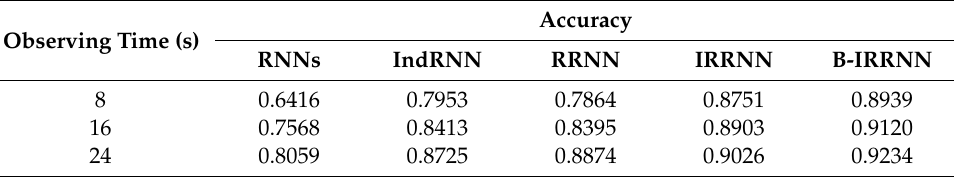
Table 5. Classification accuracy of four algorithms when t beg = 250